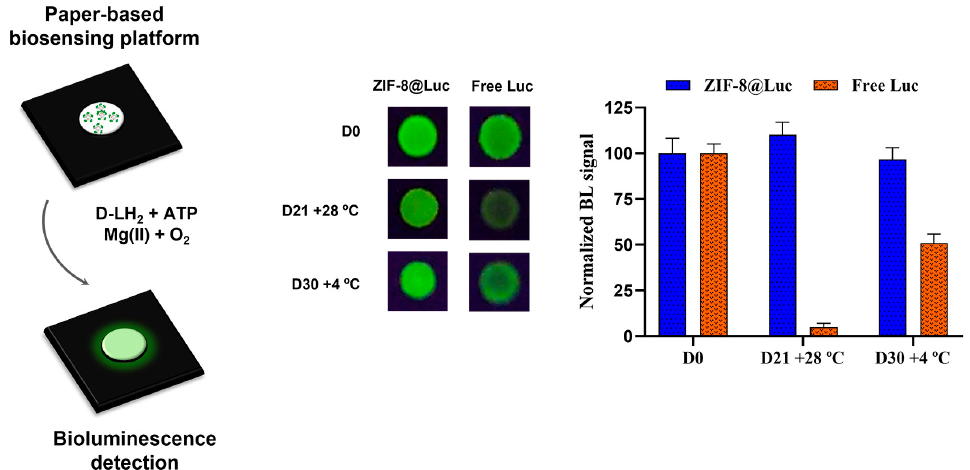
Figure 1. ZIF-8@Luc paper-sensing platform for adenosine triphosphate (ATP) quantification. Representative images of the ZIF-8@Luc paper acquired with the smartphone and stability studies of ZIF − 8@Luc in comparison with the Luc paper sensor without ZIF − 8.